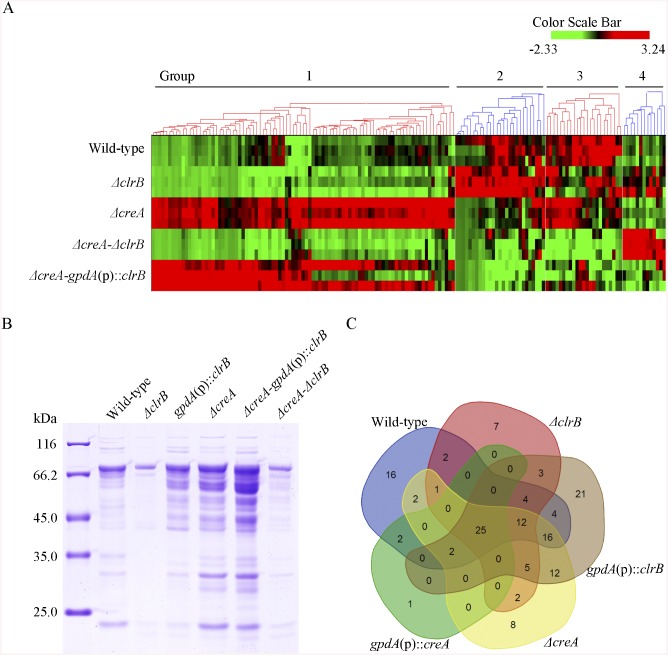
Heatmap of cellulose regulons and protein profiles of culture supernatants from P. oxalicum strains containing mutations of clrB or/and creA genes.(A) The hierarchical clustering of expression patterns for the 155 increased genes of cellulose regulon in the mutants versus wild-type strain. Hierarchical clustering analysis was performed using software HCE3.5. Heat maps showing log (RPKM) from minimum (bright green) to maximum (red) revealed four gene sets. (B) SDS-PAGE of proteins from unconcentrated culture supernatants of wild-type strain and clrB or/and creA mutants when cultured on glucose for 22 hours then shifted to cellulose for 96 hours. (C) Venn diagram from analysis of secretomes of culture supernatants from P. oxalicum mutants. The loading samples were normalized to same concentration with buffer.